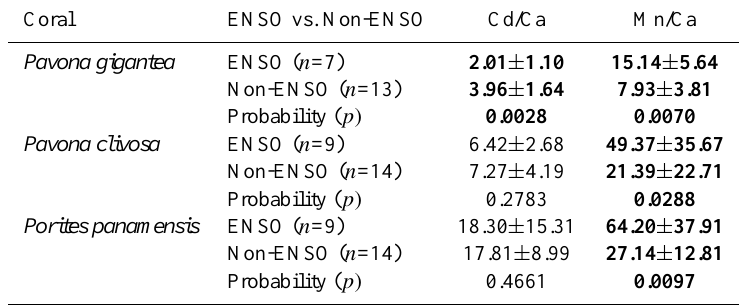
Table 3. Comparison between average ( ± 1s.d.) Cd/Ca and Mn/Ca ratios (nmol/mol) for ENSO and non-ENSO years in corals collected from Cabo Pulmo reef. The probability values of the two sample student’s t-tests are included. The trace metal ratios for the years that are statistically different ( p ≤ 0 . 05) between ENSO and non-ENSO conditions are marked in